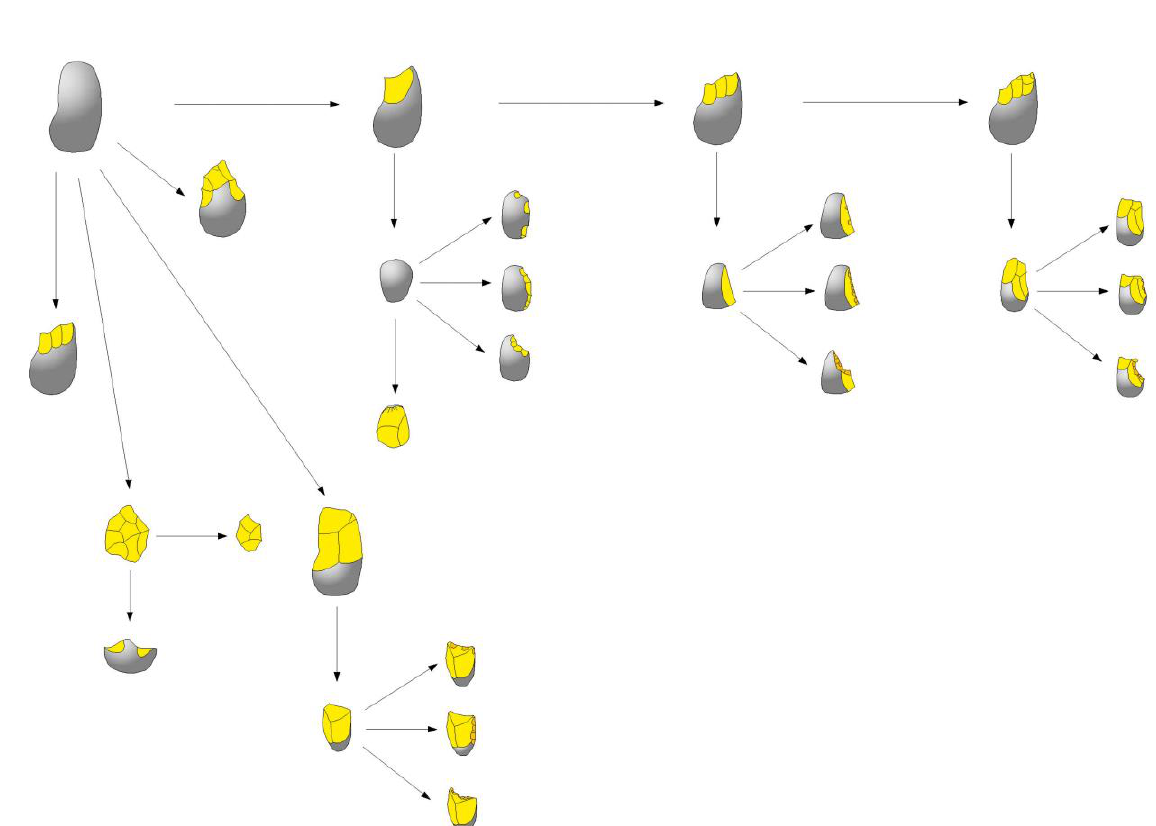
Figure 4. Reduction sequences and their variants recorded in Ribeira da Ponte da